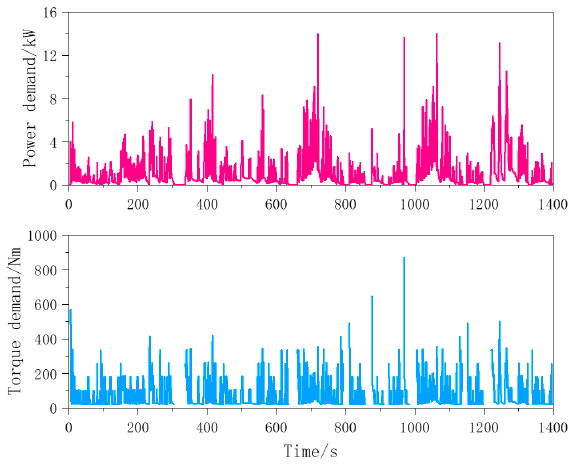
Figure 12. The demand torque/power of Harbin urban passenger driving cycle (HUPDC).